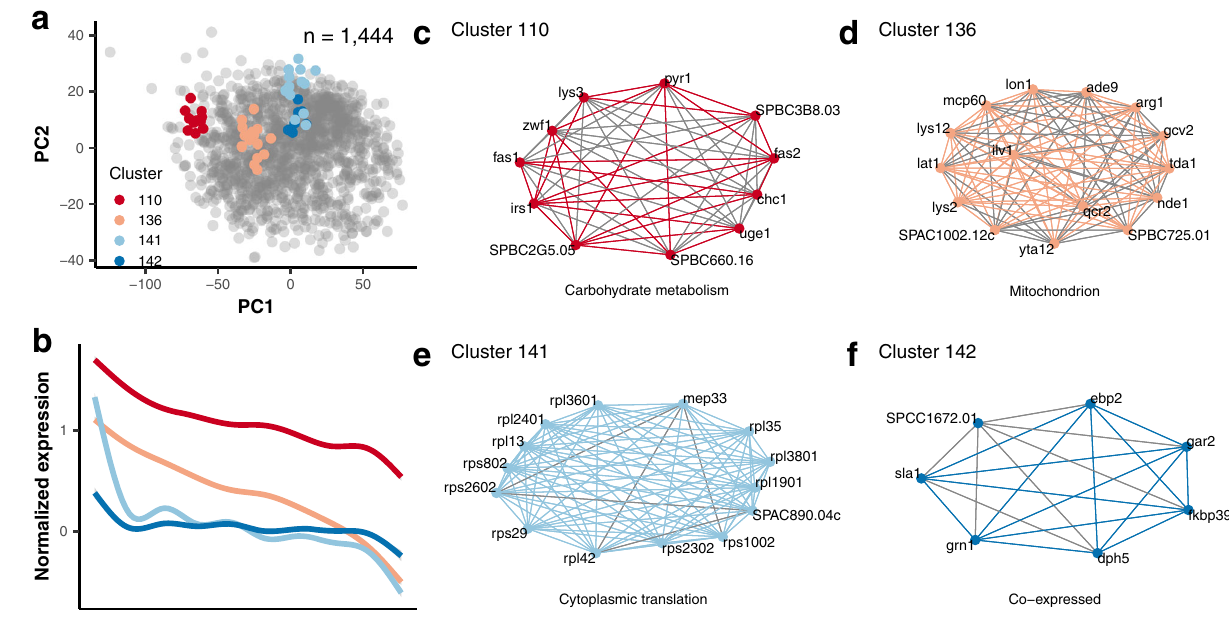
Fig. 3 | Protein co-expression clusters determined by neural network-based clustering allow improved annotation. a Principal component plot of the 1444 protein groups quanti fi ed in at least 1894 knockout strains (57% of all knockout strains). Principle component analysis (PCA) was performed based on the z-score transformedabundancesoftheproteinsacrosstheknockoutstrains.Fourselected self-organizing map (SOM) clusters are highlighted in different colors and contain